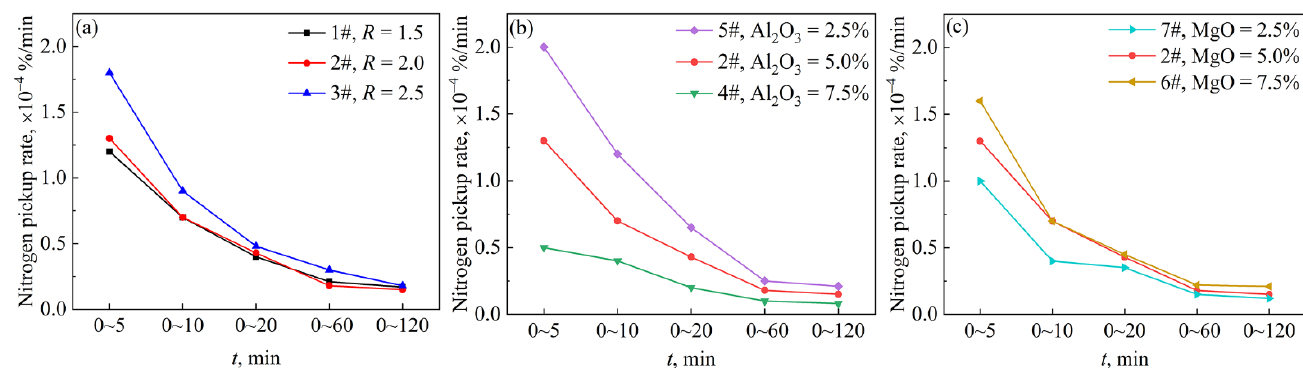
Figure 3. Nitrogen pickup rate of molten steel in different tests ( a ) different basicity slags; ( b ) different Al 2 O 3 content slags; ( c ) different MgO content slags.